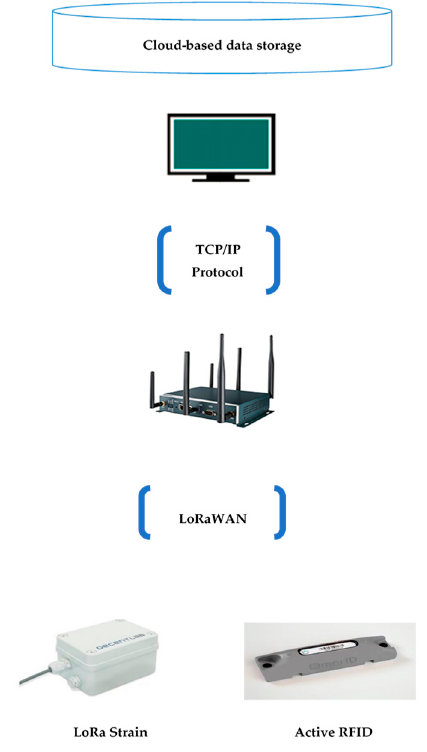
Figure 4. The architecture of the data transmission